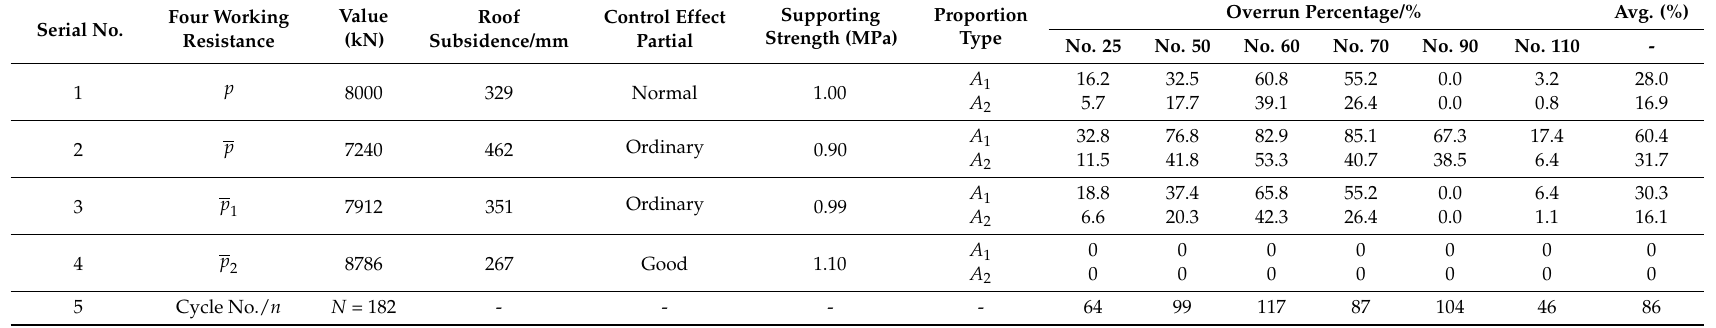
Table 2. The ratio of six key supports resistance at end of cycle exceeding four values and control effect partial in working face in Jindi mining 1313 working face. Serial No.